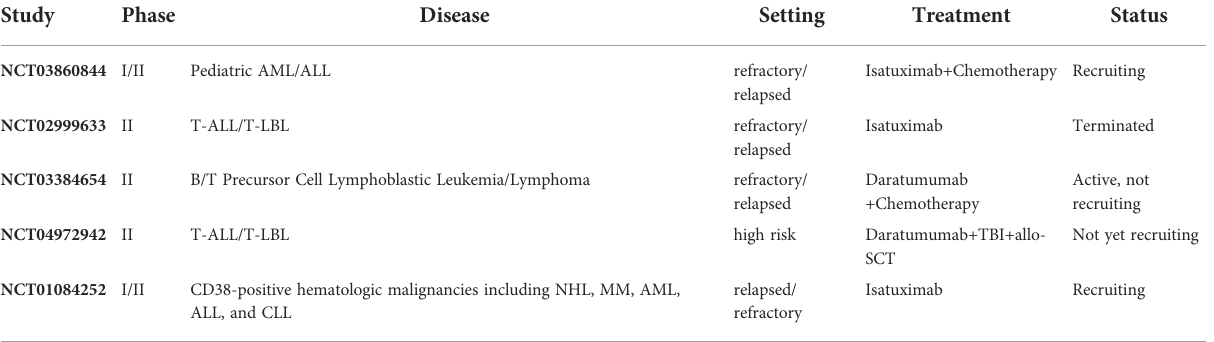
TABLE 2 Clinical trials of CD38 mAbs in